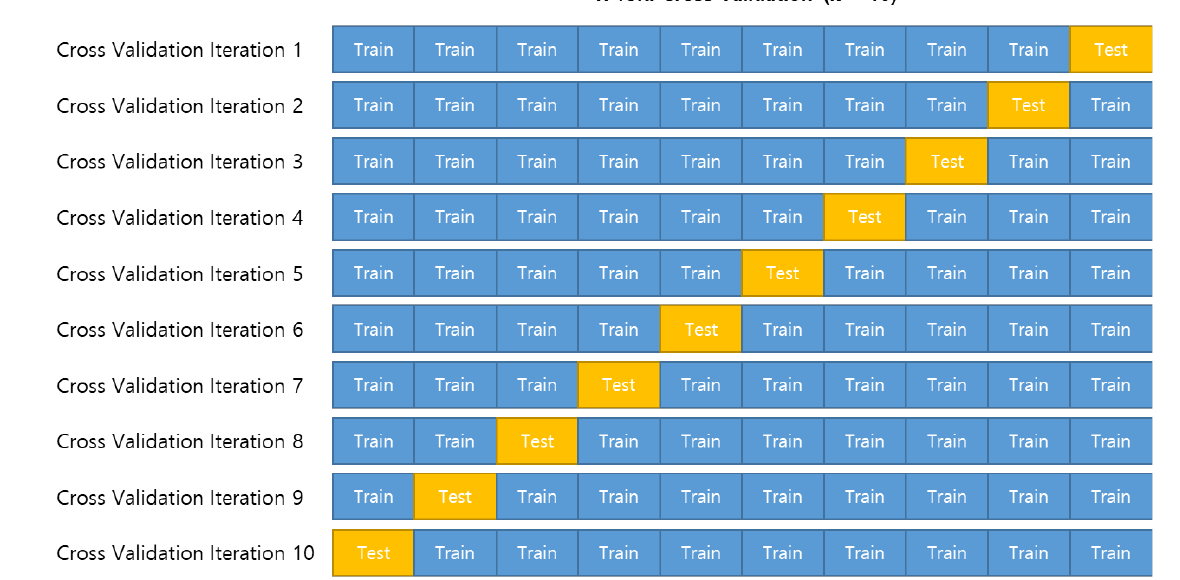
Figure 6. Overview of the k-fold cross validation applied.